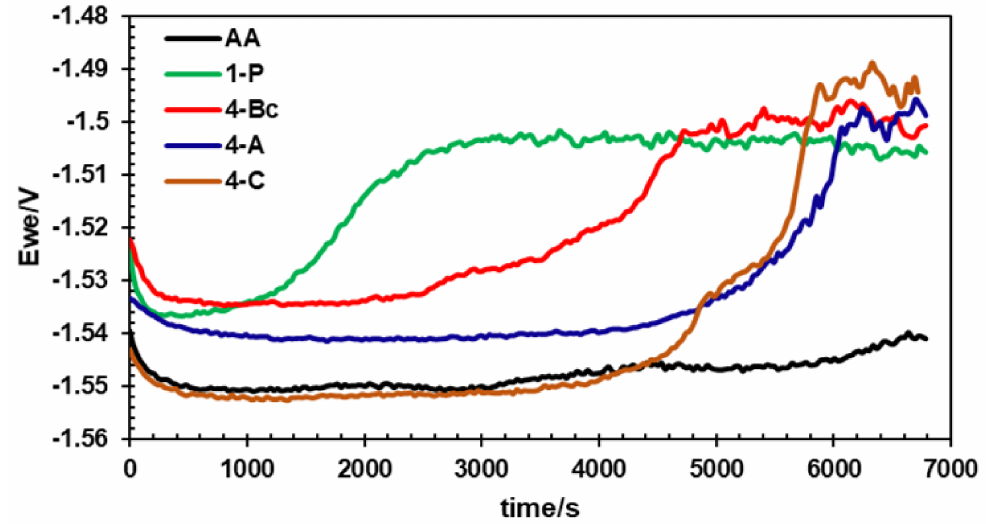
Figure 7. OCP curves of ZK30 alloy before and after ECAP processing.